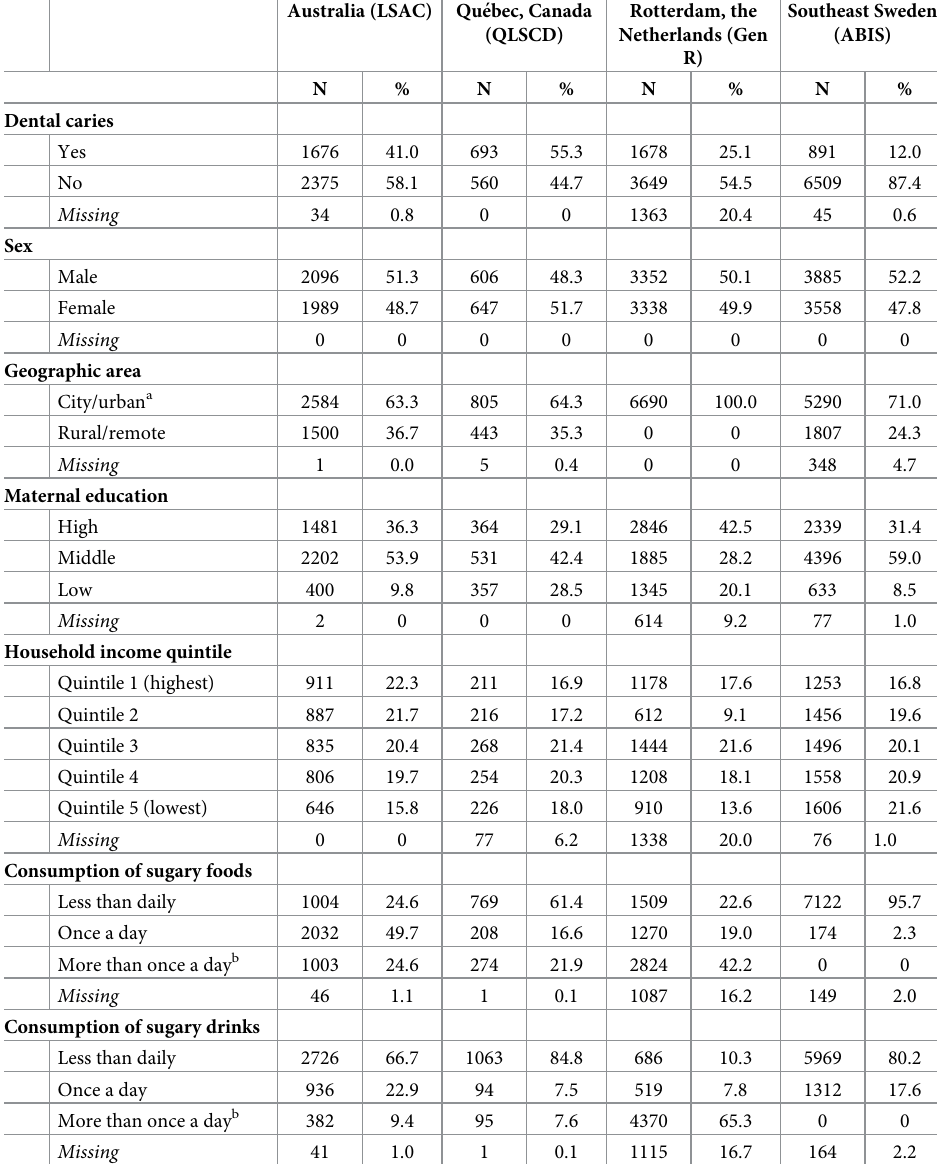
Table 2. Participant details for each